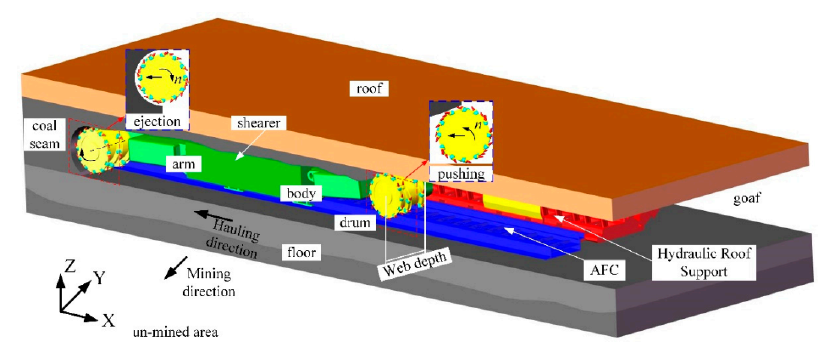
Figure 1. Schematic of shearer working in coal face.